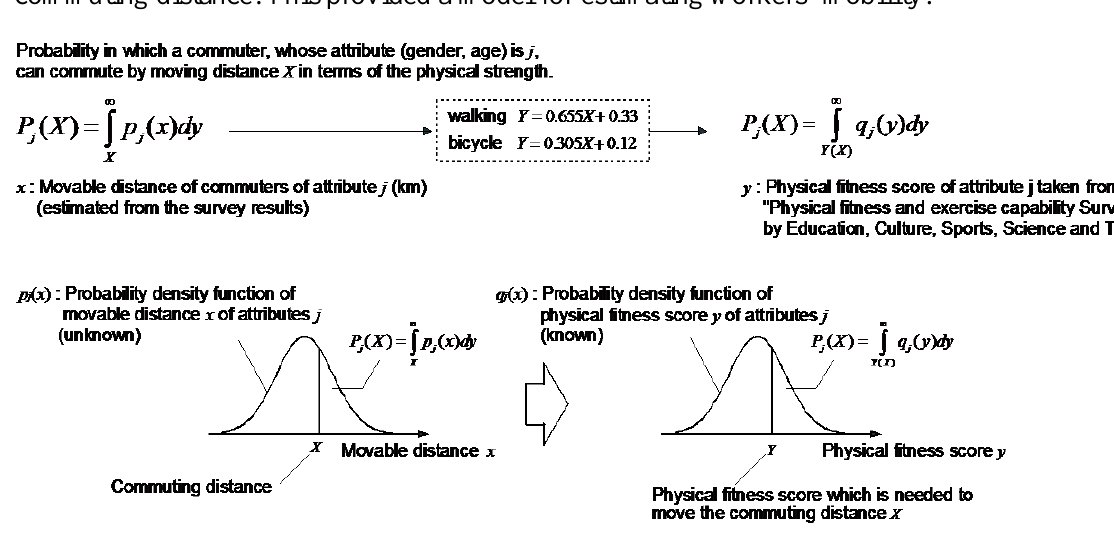
Figure 6. Component analysis of locomotive capability